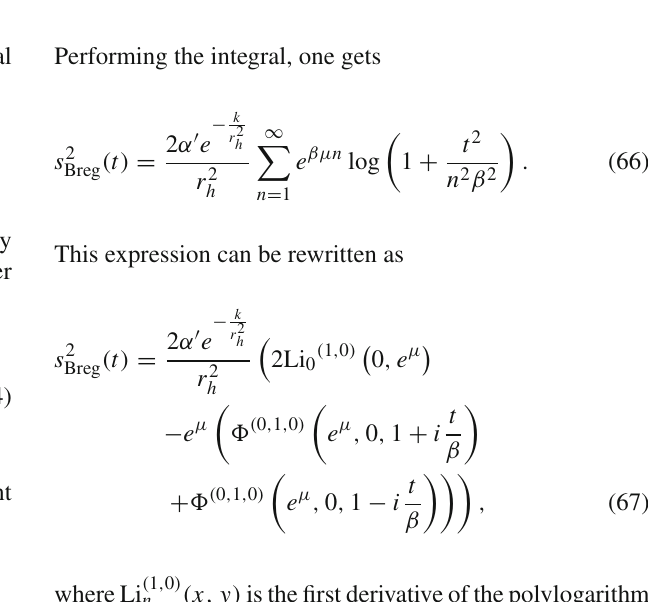
was considered although for zero chemical potential. Lower left and right panels: results achieved in this work, Eq.(45), considering both backreaction and finite chemical potential with μ = 1 and μ = 2,